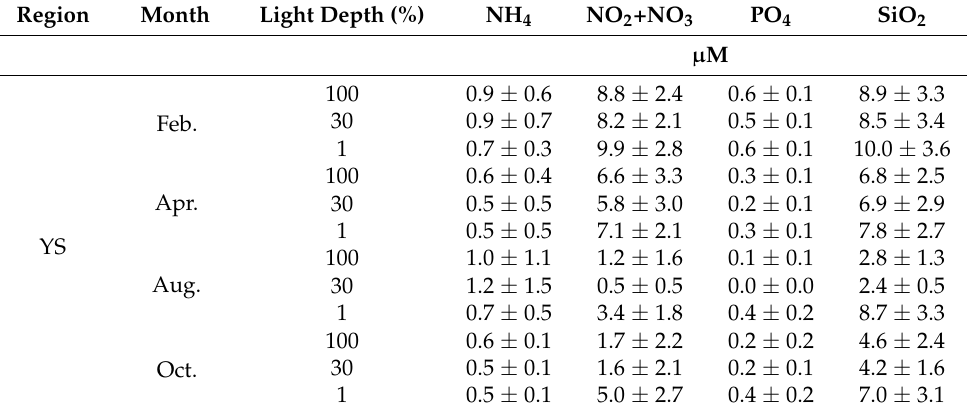
Table 2. The dissolved inorganic nutrient concentrations averaged from each light depth (100, 30, and 1%) in the YS, the SS, and the EJS,